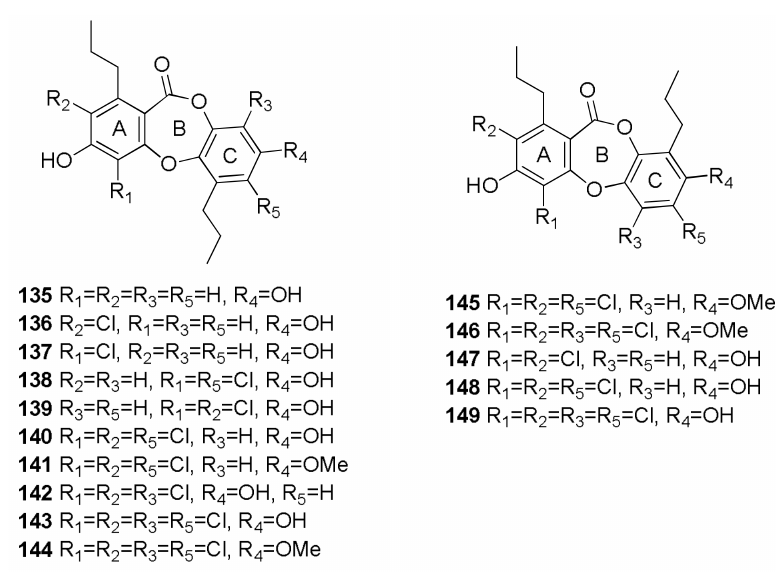
Figure 10. The structures of spiromastixones A–O ( 135 − 149